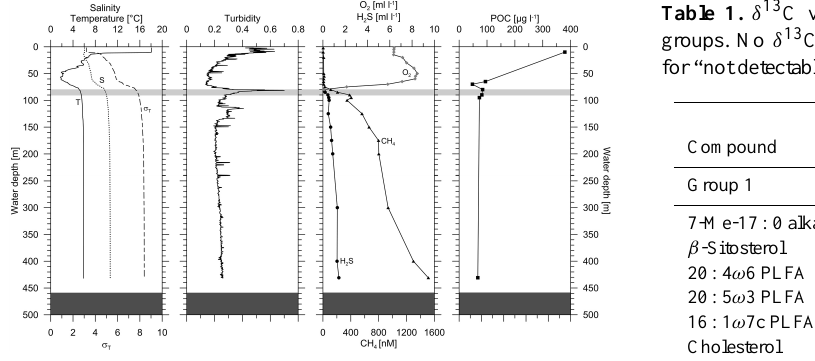
Figure 2. Physicochemical characteristics of the Landsort Deep wa- ter column in summer 2011. The suboxic zone is shaded light grey. Temperature and methane data were partially taken from Jakobs et al. (2014).